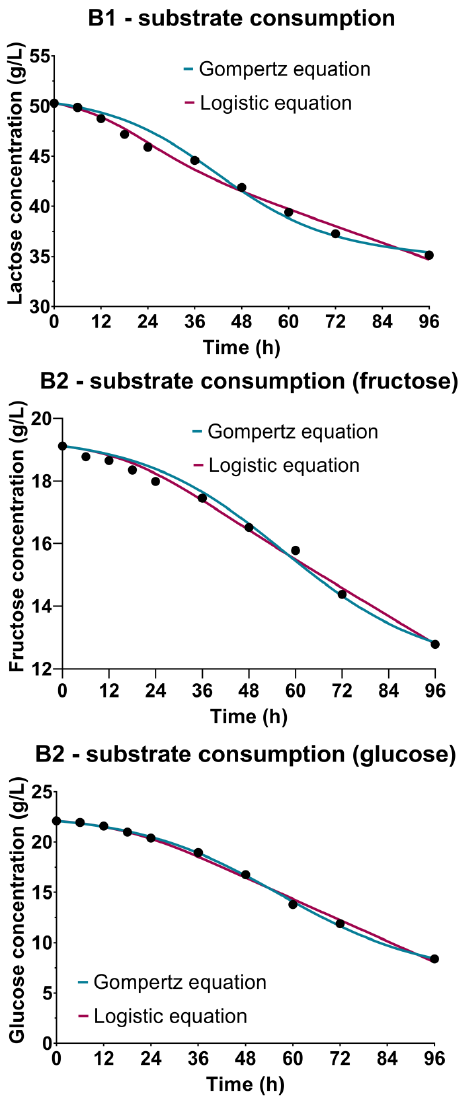
Figure 3. Bioprocess kinetics in terms of sugar substrate consumption during the Bacillus sp. BioSol021 cultivations in a 16 L bioreactor using the food industry effluents-based media: B1—cheese whey from dairy industry, B2—winery flotation wastewater.